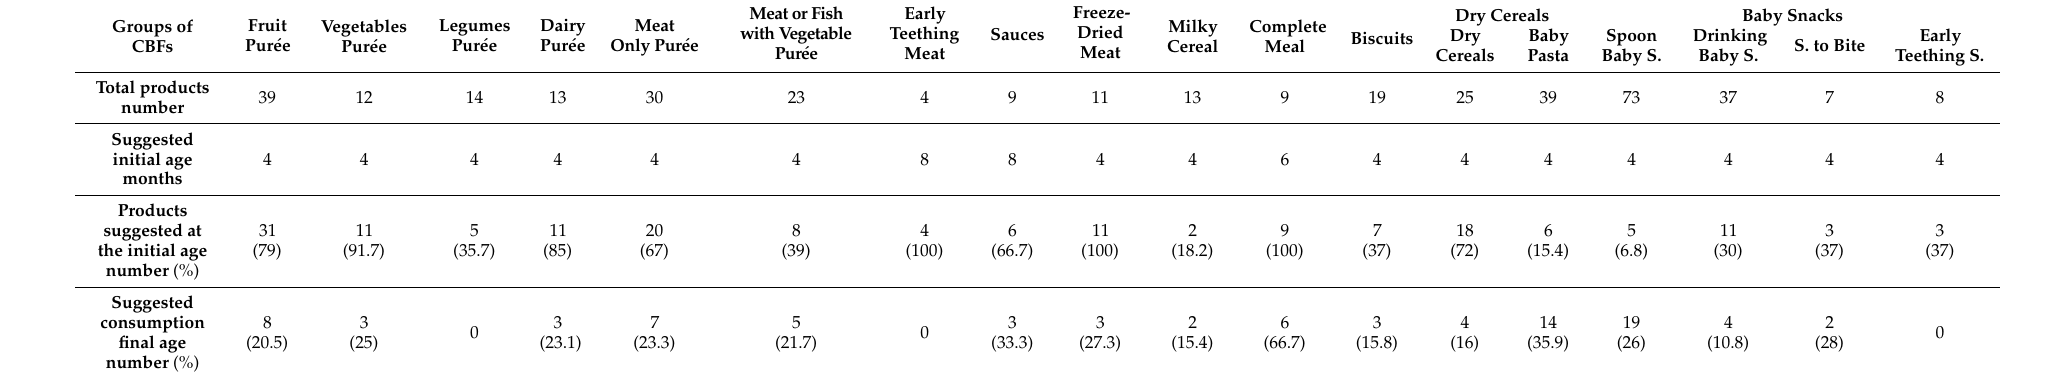
Table 1. Suggested initial and final age for different types of baby food consumption. S.: Snacks.